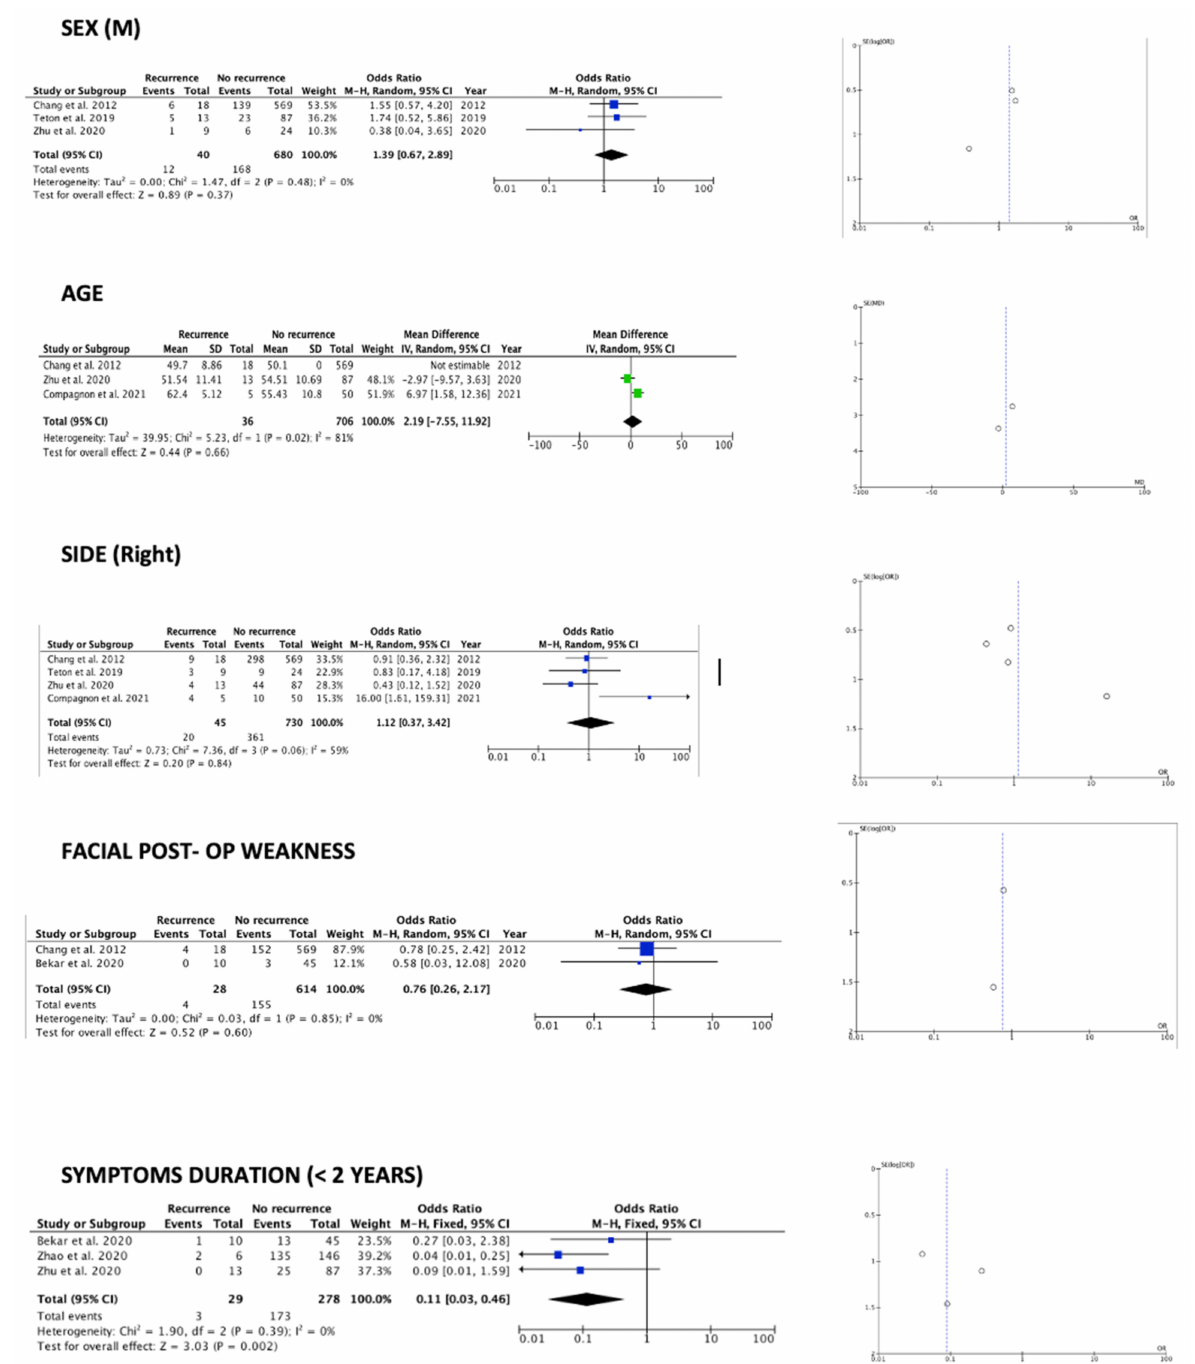
Figure 2. Forest plots and funnel plots for investigated clinical variables